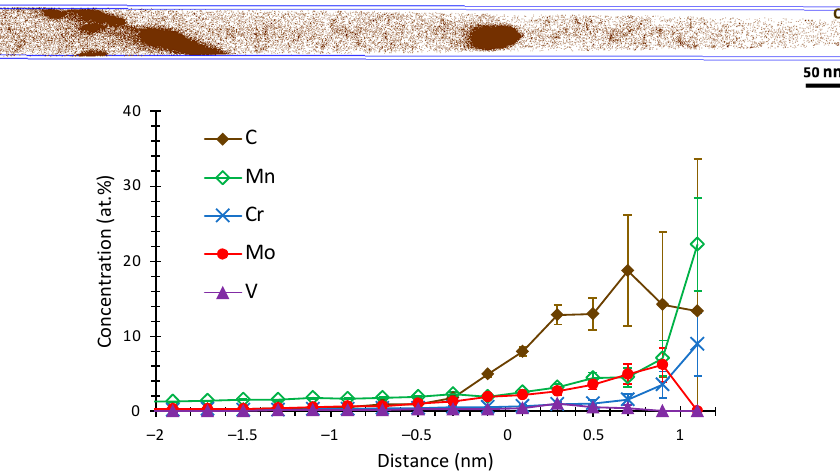
Figure 4. Atom map showing all C atoms in the sample aged 4 h at 500 °C ( top ). Cementite carbides at a lath boundary ( left ) and one large isolated carbide ( right ) are seen. There are also very small carbides in the matrix, for which a proxigram is presented ( bottom ).